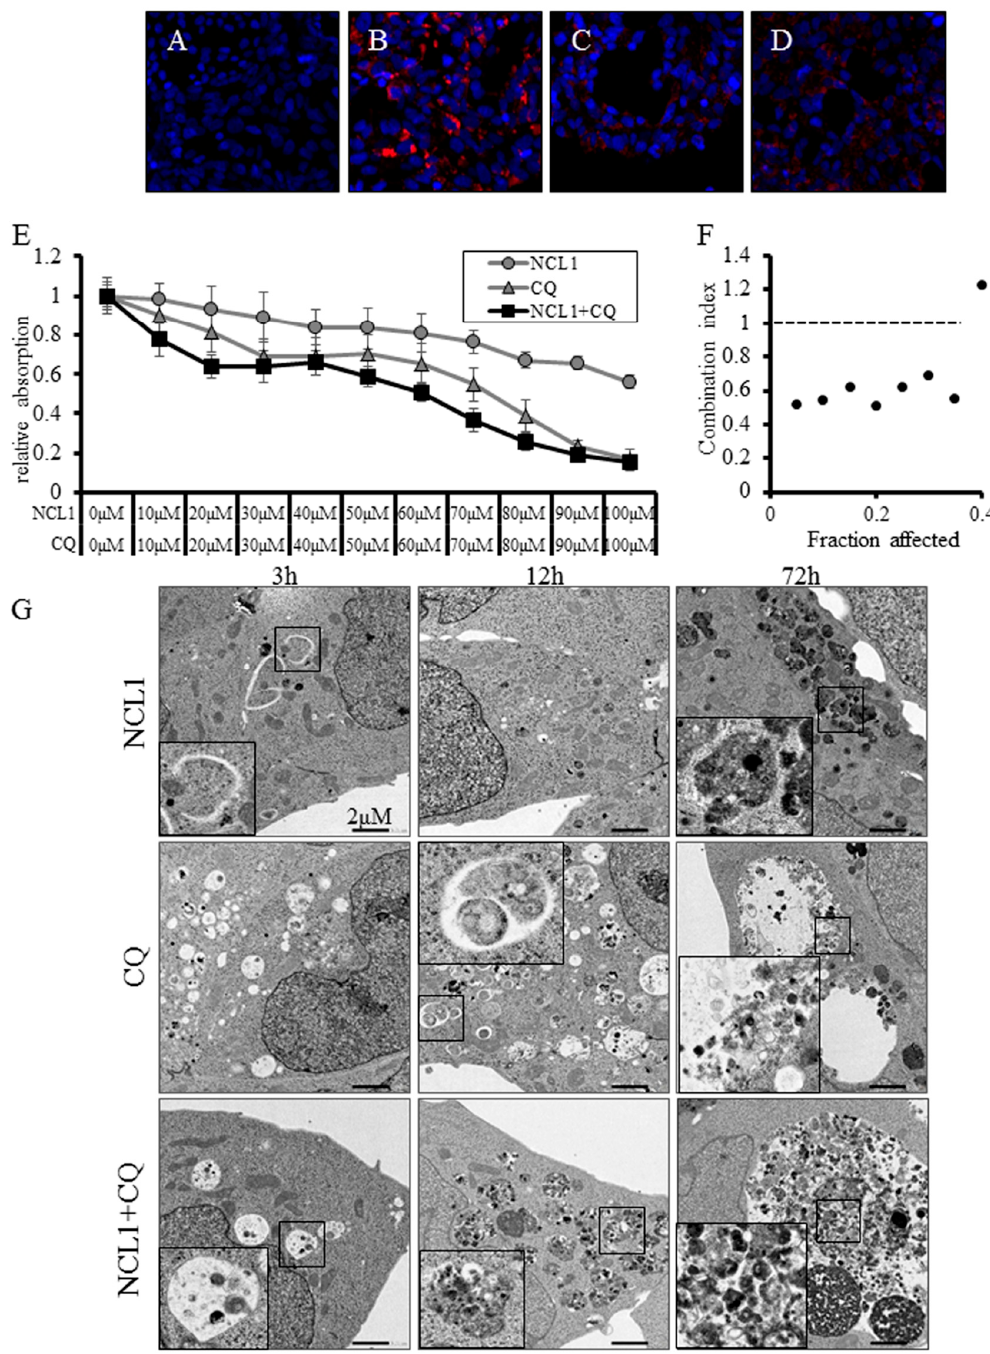
Figure 3. ( A – D ) Detection of the activation of lysosomes using LysoTracker analysis in 22Rv1 cells. Cells were treated with vehicle control ( A ), 50 µ M NCL1 ( B ), 50 µ M chloroquine (CQ) ( C ), or with 50 µ M NCL1 and 50 µ M CQ ( D ). Blue: nuclei, red: lysosomes. ( E ) 22Rv1 cells were treated with 50 µ M NCL1 and/or 50 µ M CQ. A WST-8 assay, in which the dye absorption rate positively correlated with cell viability, revealed that a combination of NCL1 and CQ decreased cell growth. ( F ) A combination index was calculated from the results of the WST-8 assay in Figure 3E. The combination of NCL1 and CQ showed a synergistic effect. ( G ) Cells were treated with 50 µ M NCL1 for 3 h, 12 h, and 72 h. Three hours after NCL1 treatment, the formation of autophagosomes was noted by transmission electron microscopy (TEM). The cytoplasm also showed increased numbers of structures (visible in the 72 h figure) from 24 h to 72 h. Scale bar is 20 µ m.